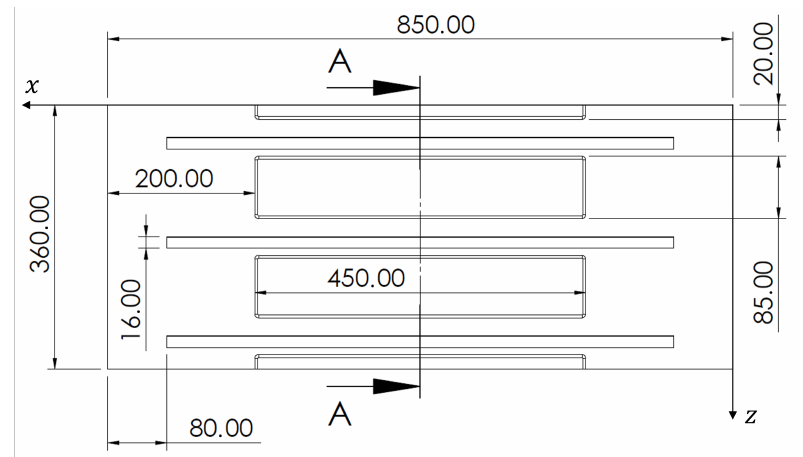
Figure 2. Geometry—Top view with all the dimensions in mm.